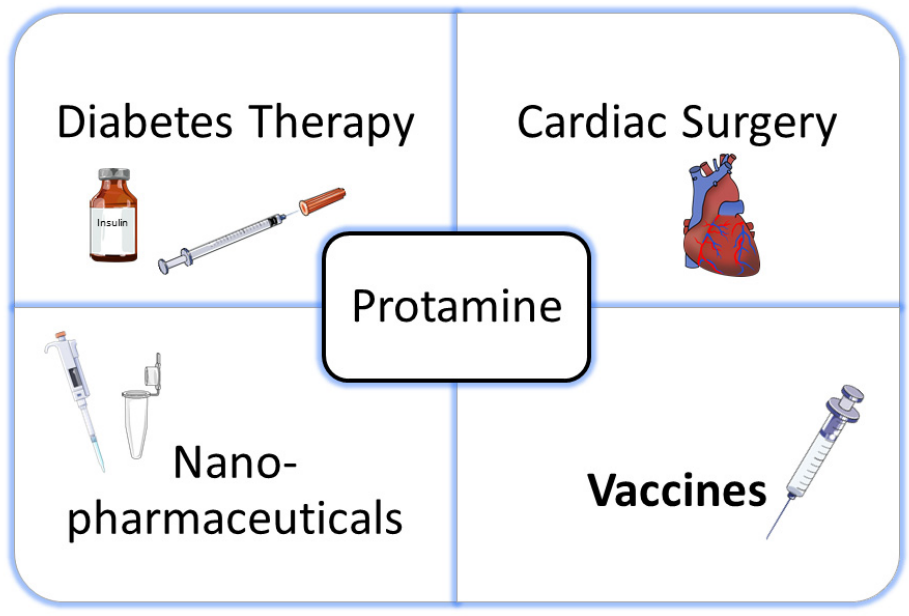
Figure 1. Application fields of protamine. This review will especially focus on protamine in nanopharmaceuticals as well as its approach in vaccines.